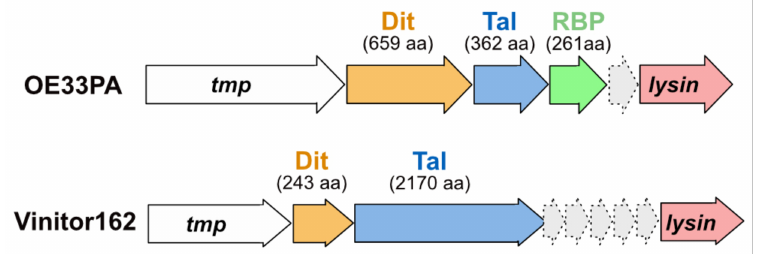
Figure 1. Schematic representation and assignment of adhesion device-encoding genome regions. Genes encoding adhesion device components are located between tmp and lysin . Orange arrows represent open-reading frames (ORFs) encoding Dits, blue arrows represent ORFs encoding Tals, and the green arrow represents the ORF encoding the OE33PA RBP. Light grey arrows represent the ORFs encoding hypothetical proteins. The number of protein residues involved is indicated (aa: amino